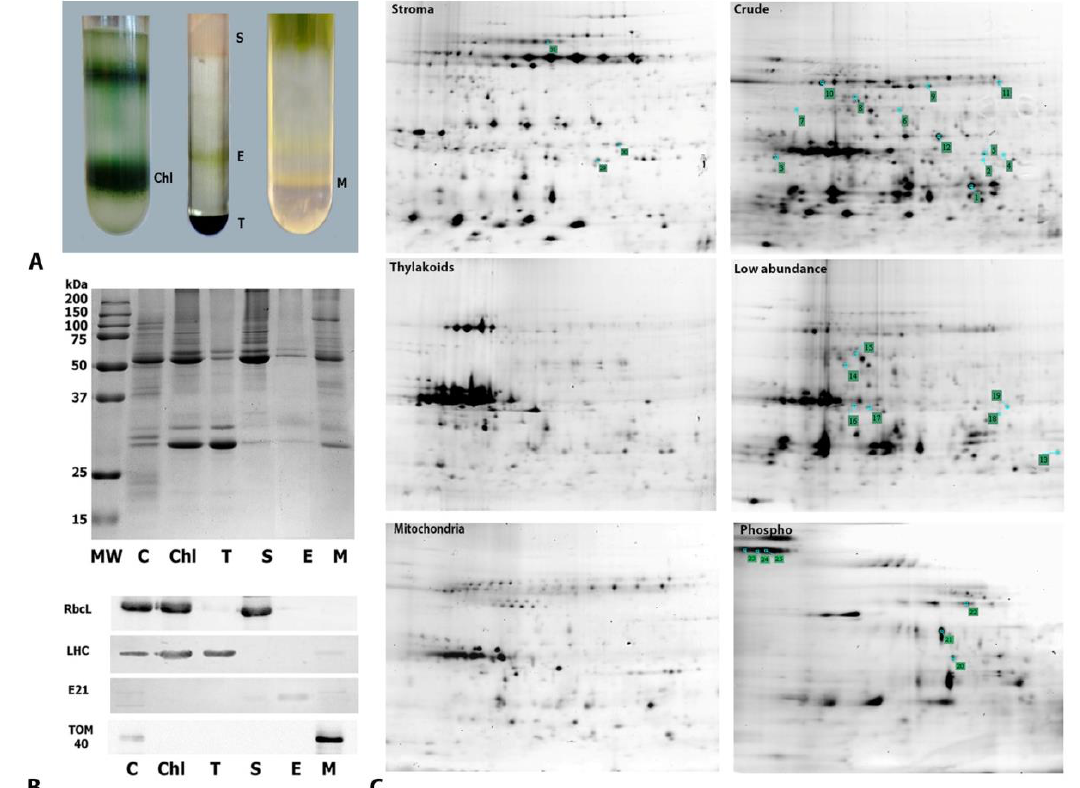
Figure 3. Extraction of intact organelles and their subcompartments from H. rhodopensis and gel- based proteomic analyses. ( A ) Purification of organelles and chloroplast subcompartments from H. rhodopensis . (Left) Percoll gradient allowing the separation of intact (bottom) and broken (top) chlo- roplasts (chl). (Middle) Percoll-purified chloroplasts fractionated into stromal (S), envelope (E), and thylakoid (T) subfractions using a sucrose gradient. (Right) Purification of the mitochondrial (M) fraction using a Percoll gradient. ( B ) SDS-PAGE analysis of organelle (upper panel) and suborga- nelle fractions and immunoblotting for the evaluation of cross-contamination (lower panel). MW —